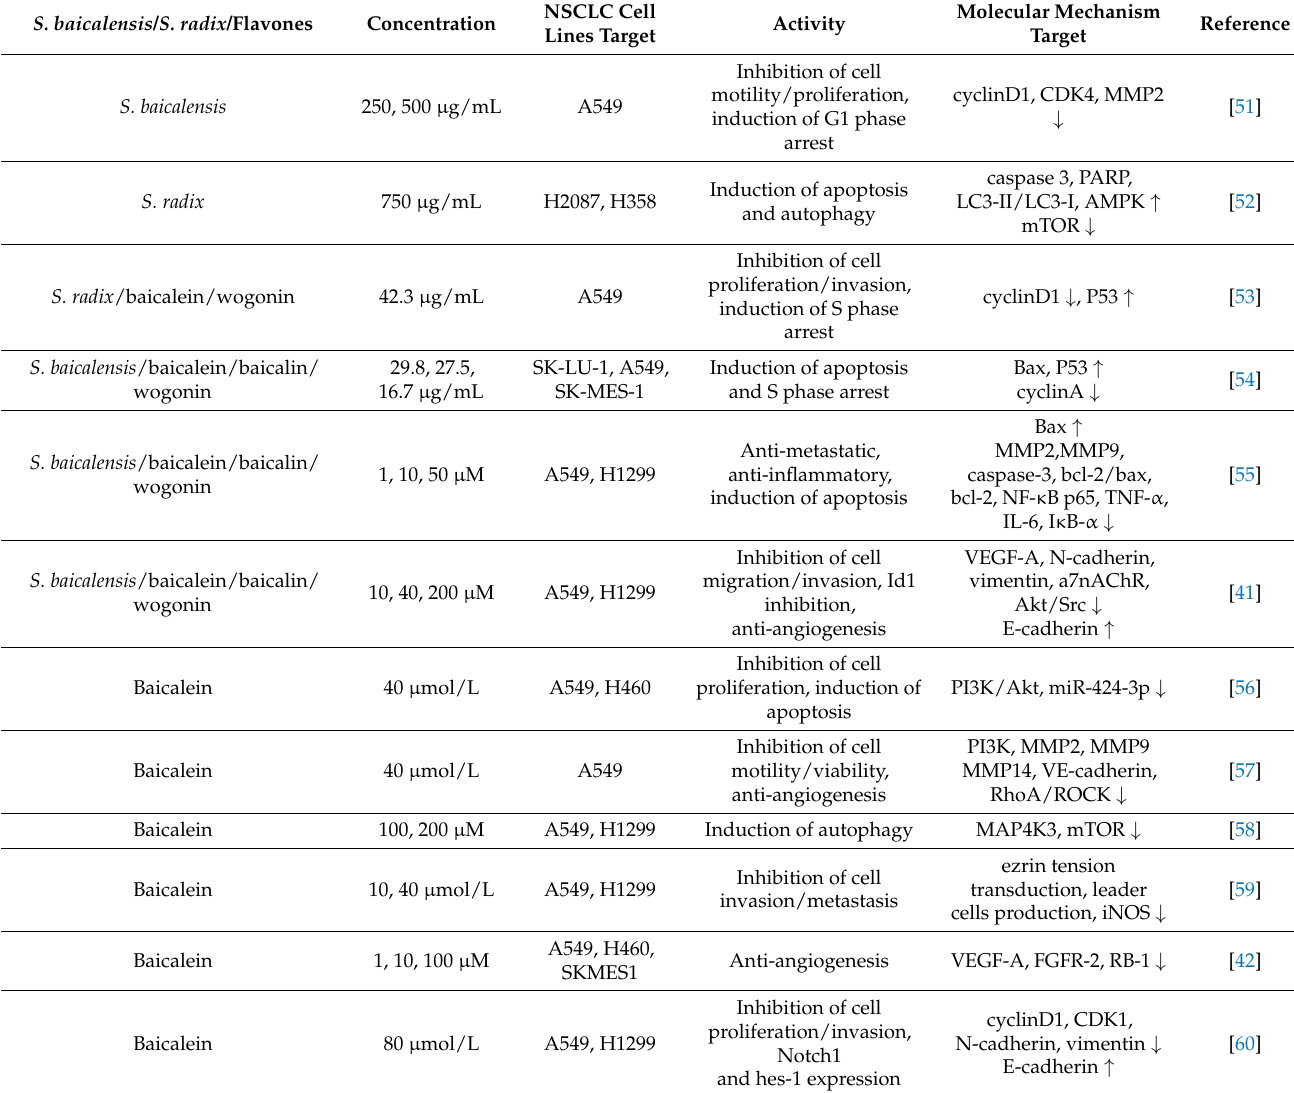
Table 2. Anti-lung cancer activity of S. baicalensis and their flavone compounds in nicotine-induced NSCLC. S. baicalensis / S. radix